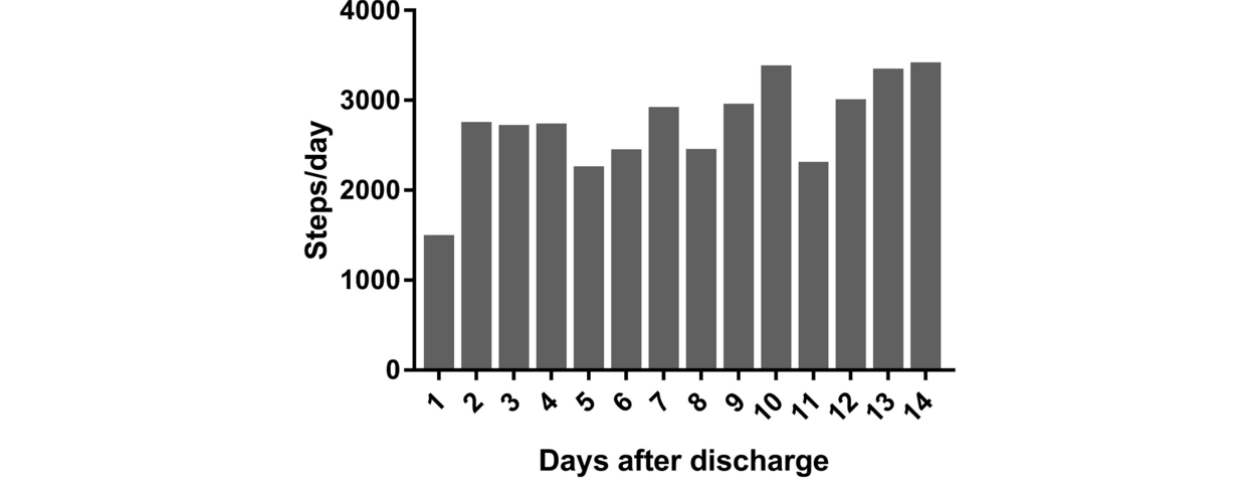
Figure 4. Daily step count during the 14-day study period for patients with valid data ( ≥ 4 day out of a possible 7 for each of the 2 weeks). N=8 for day